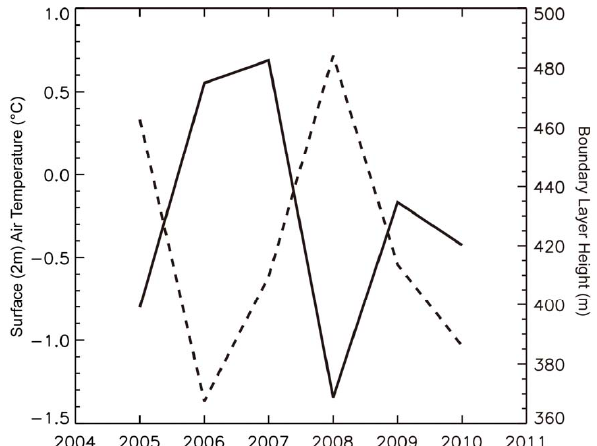
Fig. 6. Variations from 2005 to 2010 of January mean surface (2m) air temperature (solid line) and planetary boundary layer height (dashed line) over Northern East